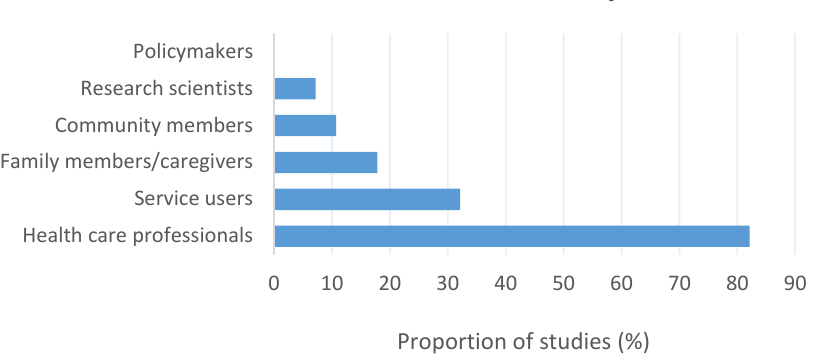
Figure 2. The stakeholder groups investigated across the included literature and the proportion (%) of studies consulting each group.